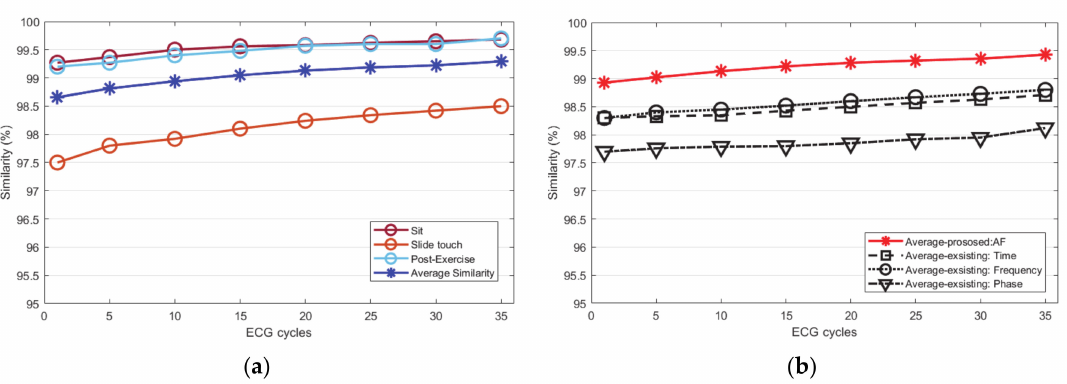
Figure 12. Mahalanobis distance similarity performance analysis: ( a ) similarity of each status before normalization ( b ) similarity after normalization (proposed method, existing method).